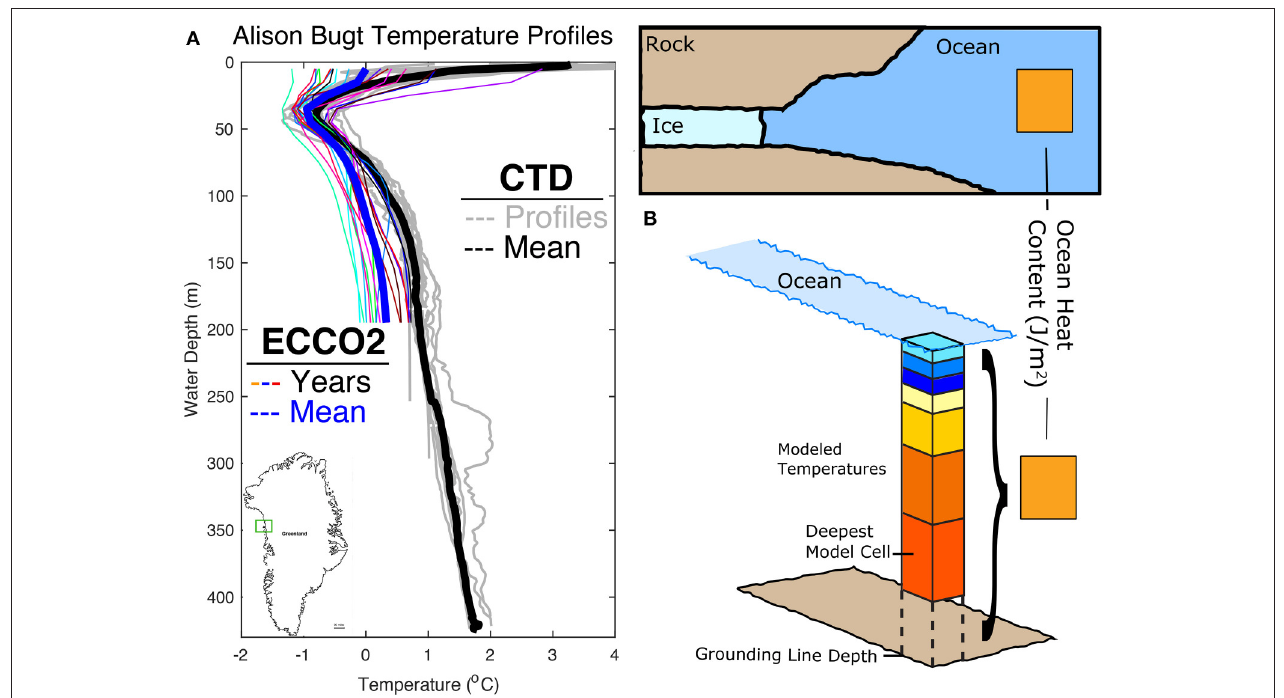
FIGURE 2 | (A) Temperature profiles from both the ECCO2 model and a SeaBird SBE19 CTD for Alison Bugt (74.5828N, − 57.0920E). ECCO2 model annual mean temperatures for years 1993–2009 (colored) with climatology in blue. CTD temperature profiles from July 2014, located along the fjord centerline between 18 and 45 km from the glacier terminus, are shown in gray (mean in black). (B) Schematic illustrating the calculation of ocean heat content. For each glacier, an ocean model column is chosen considering both horizontal distance and maximum water depth. OHC is the vertical integral of the difference between each layer’s in situ temperature and the freezing point of seawater at that